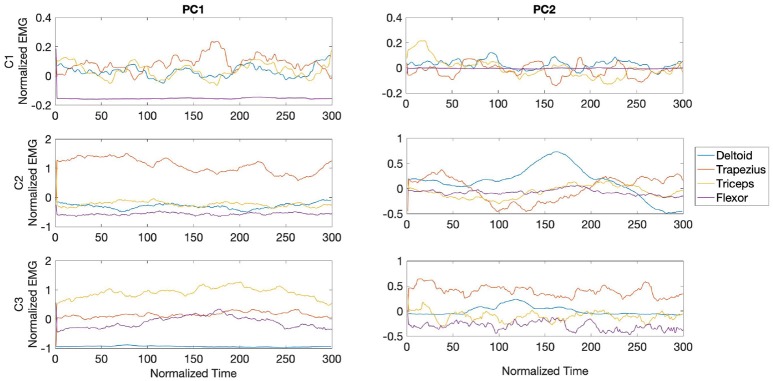
Waveforms showing the two principal components of muscle activation across the deltoid (blue), trapezius (orange), triceps (yellow), and wrist flexor (purple) muscles for cellists C1-3 in the slow phase (bottom panel in Figure 8). Each panel shows the activation pattern centered around bow onset (150 ms).